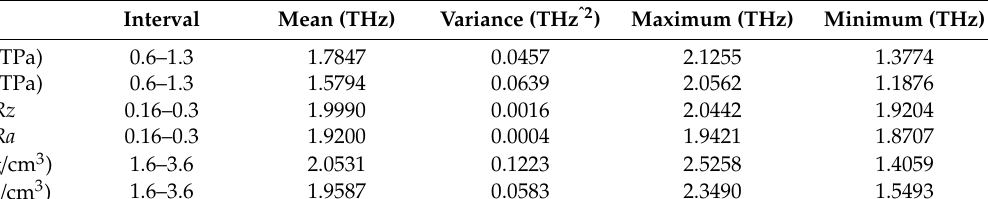
Figure 9. Probability density distribution of natural frequency for uncertainty analysis ( a ) is for Bz and Ba , ( b ) is for Dz and Da , ( c ) is for Wz and Wa , ( d ) is for Hz and Ha , and the unit for the natural frequency is THz.